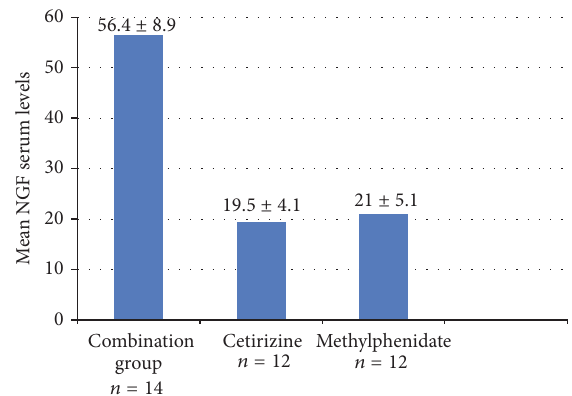
Figure 2: Serum NGF values in subjects treated with methyl- phenidate/cetirizine, methylphenidate, or cetirizine compared to